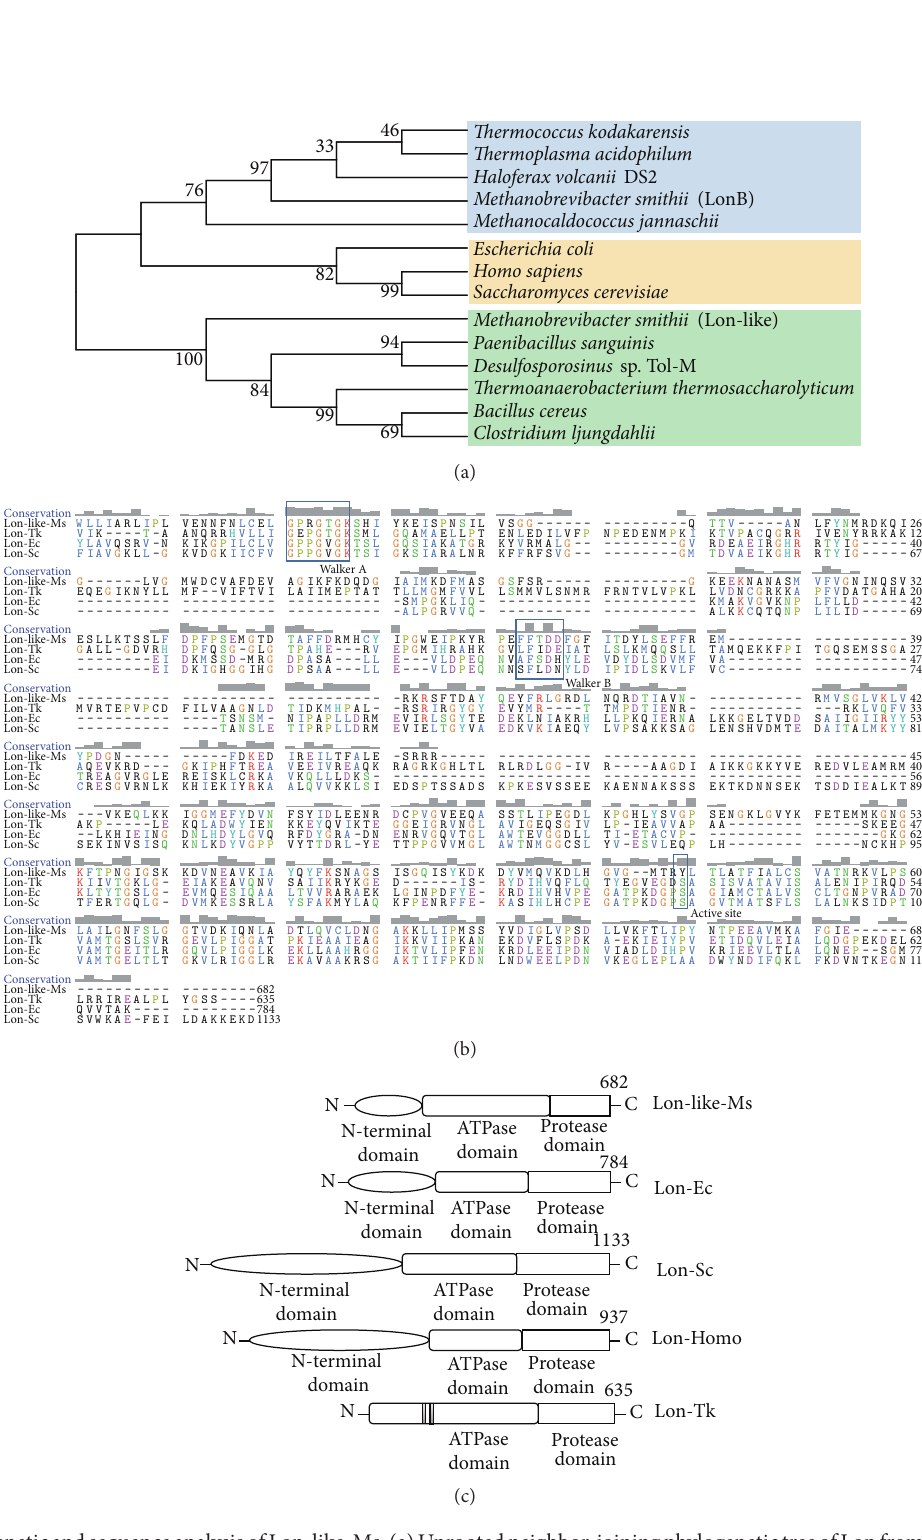
Figure1:PhylogeneticandsequenceanalysisofLon-like-Ms.(a)Unrootedneighbor-joiningphylogenetictreeofLonfromtheLonA(yellow), LonB (blue), and Lon-like (green) families, generated using MEGA5. The optimal tree with a branch length sum of 13.47550492 is shown. The percentage of replicate trees in which the associated taxa clustered together in the bootstrap test (1000 replicates) is shown next to the branches. (b) Lon-like-Ms and protease Lon sequences from T. kodakarensis KOD1, E. coli , and yeast were aligned. The Walker A, Walker B, and the possible active site are shown in the rectangles. The conservation level of each residue is indicated by the height of the bars above each residue. The number at the ending of each line of amino acids indicates the number of the amino acid residues. (c) Putative domains of Lon proteases from M. smithii (Lon-like-Ms and WP 011954752), E. coli (Lon-Ec, WP 001295325.1), yeast (Lon-Sc, NP 009531.1), human (Lon-Homo, NP 004784.2), and T. kodakarensis (Lon-Tk, WP